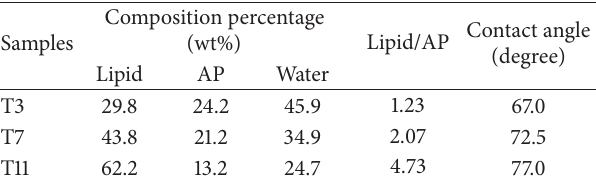
Figure 2: Viscosity of lacquer sap.